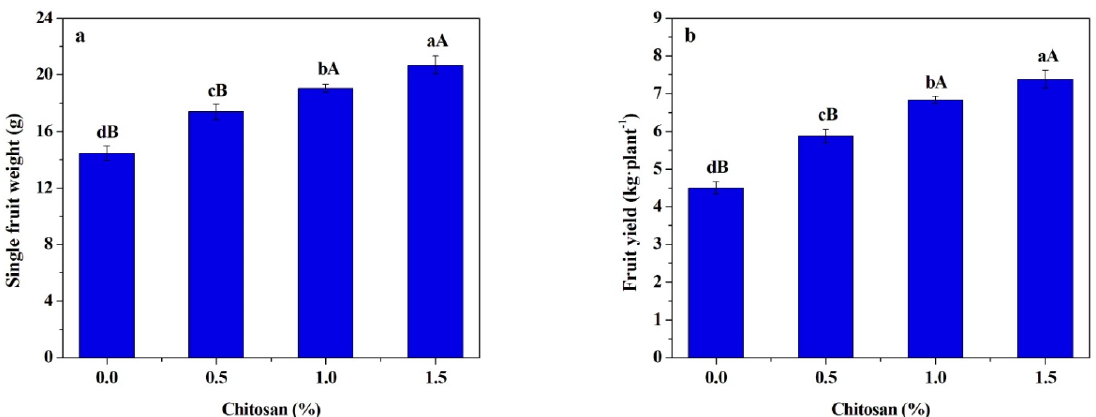
Figure 3. The effects of chitosan on single fruit weight ( a ) and fruit yield ( b ) of R. roxburghii . Values and error bars indicate the mean and SD of three replicates, respectively. Different small and capital letters indicate significant differences at 5% level ( p < 0.05) and 1% level ( p < 0.01), respectively.